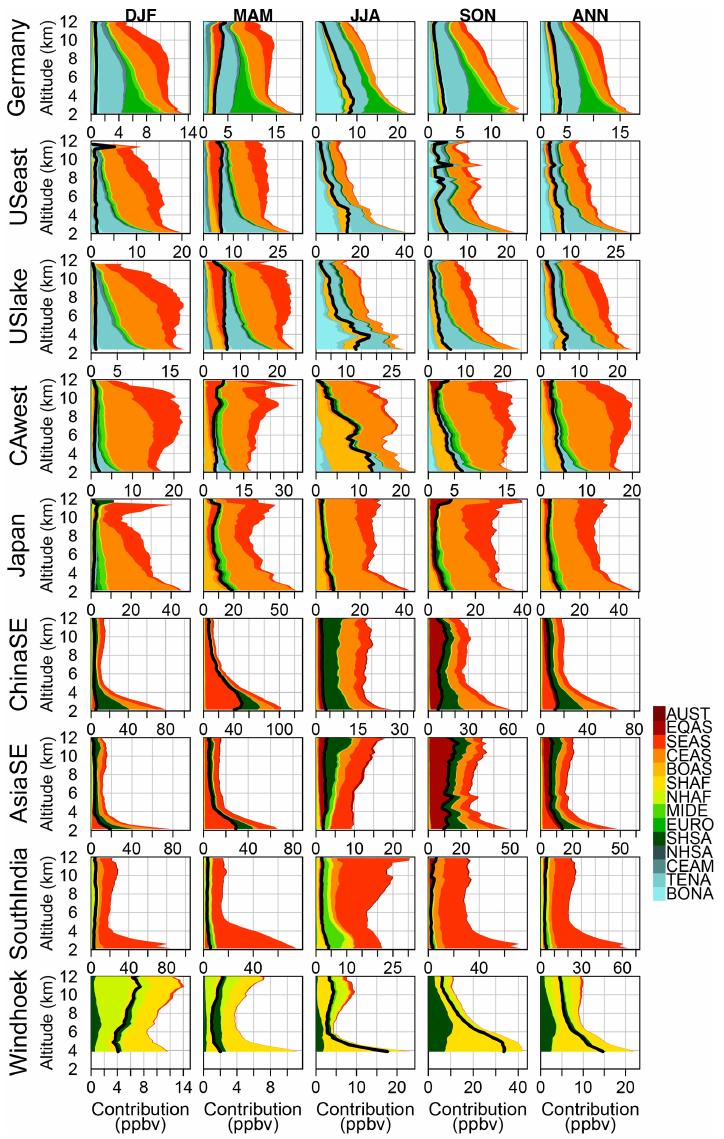
Figure 23. Climatological vertical distribution of the SOFT-IO total (C AN + BB ) contributions, averaged over the all IAGOS vertical profiles (CO > 0 ). The colours indicate the source regions. The total biomass burning contributions are shown with a black line (anthropogenic contributions are thus on the right of this black